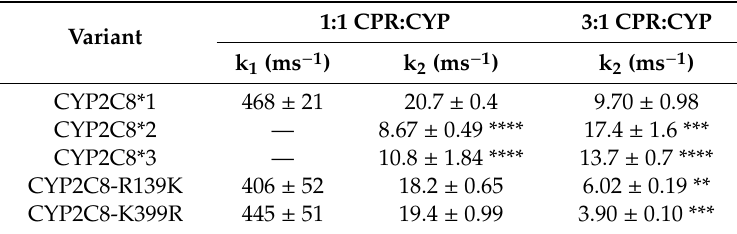
Figure 5. Stopped-flow electron transfer rate to CYP2C8 variants. ( A ) Three-dimensional plot of representative absorbance spectra from 0 to 500 s showing the increase in absorbance near 450 nm following the mixing of NADPH with a pre-incubated complex of paclitaxel-bound CYP2C8 and CPR. ( B – F ) Representative plots of the change in peak absorbance at 450 nm from 0 s to 500 s. Experiments were conducted at either a 1:1 CPR:CYP or a 3:1 CPR:CYP ratio. Data points (grey squares) are overlaid with the line of best fit (solid black line) derived from a fit of the data to either monophasic (single exponential) or biphasic (two exponential) kinetic equations in OriginLab as indicated. Table 4. Stopped-flow CO binding kinetics. Fast (k 1 ) and slow (k 2 ) rates are in units of ms − 1 . Experiments were conducted using a 1:1 and a 1:3 CYP:CPR ratios. Error represents the SEM of 3–6 experiments. Statistical significance compares to WT. ** p < 0.01, *** p = 0.001, **** p < 0.0001.